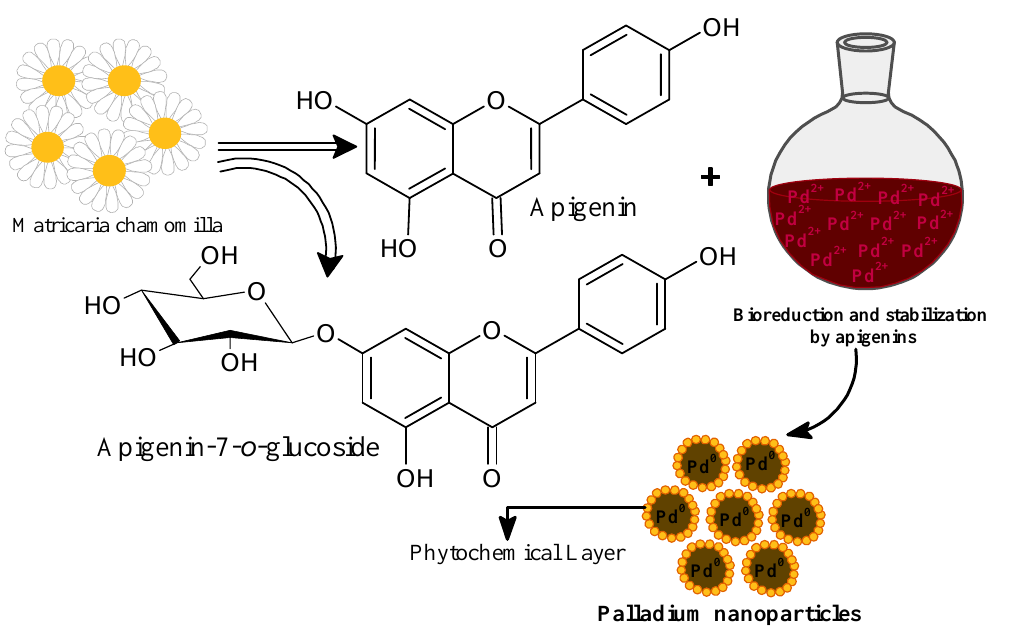
Figure 1. Bioreduction and stability of PdNPs using aqueous extract of Matricaria recutita flowers.